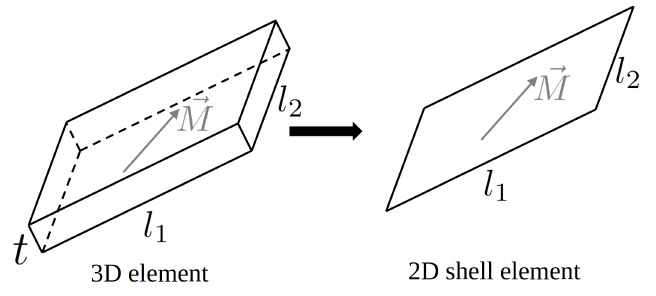
Figure 4. From volume element to shell element representation when t << { l 1 , l 2 }